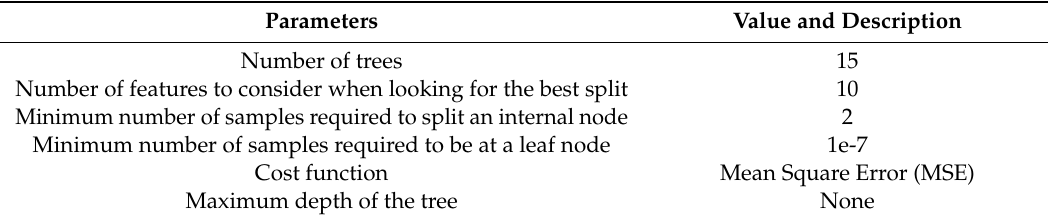
Table 4. RF parameters used in this